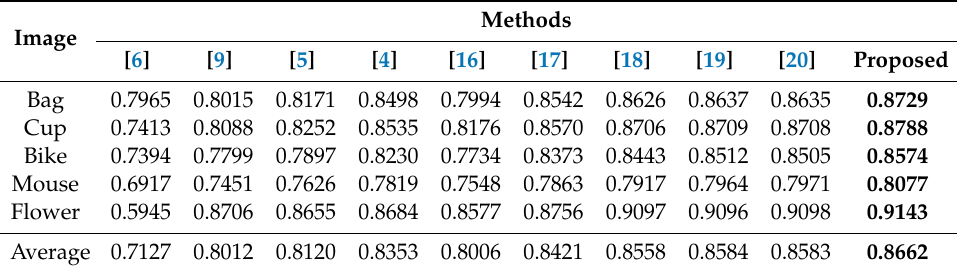
Table 6. The performance summary of different methods on the five image datasets, using Q AB/F. Image